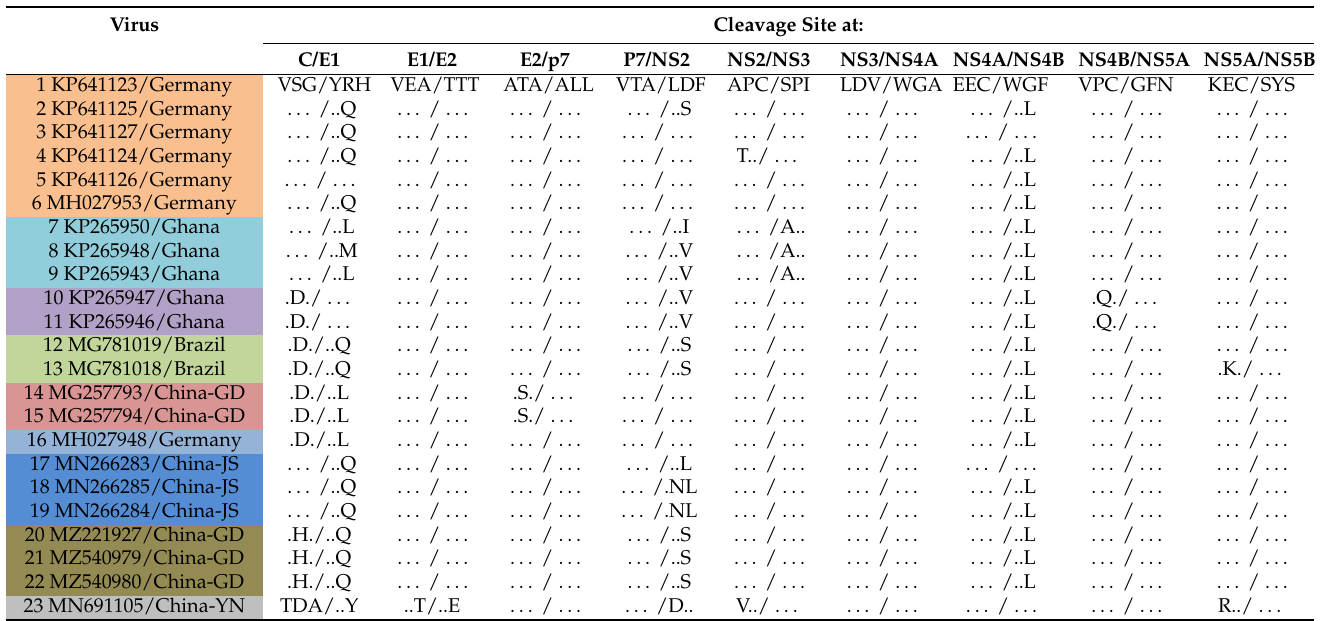
Cleavage is indicated by a slash (/). The sequences shaded with different colors indicate different subtype of BovHepV. Subtype A (